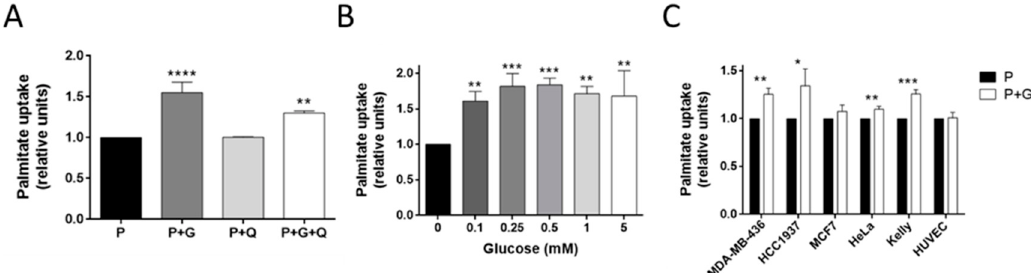
Figure 4. Effect of glucose on palmitate uptake. ( A ) Palmitate uptake in the presence of 5 mM glucose and/or 0.5 mM glutamine, or ( B ) with different concentrations of glucose in MDA-MB-231 cells. ( C ) Palmitate uptake in the presence or not of 5 mM glucose in MDA-MB-436, HCC1937, MCF7, HeLa, Kelly, and human umbilical vein endothelial cells (HUVEC) cell lines. All of the experiments were performed after 30 min of fasting and 30 min of incubation with 0.5 mM palmitate, 2 µ M BODIPY (BOron-DIPYrromethene) FL C 16 , and indicated concentrations of glucose. Data are expressed as means ± SD of three independent experiments. * p < 0.05, ** p < 0.01, *** p < 0.001, **** p < 0.0001 versus